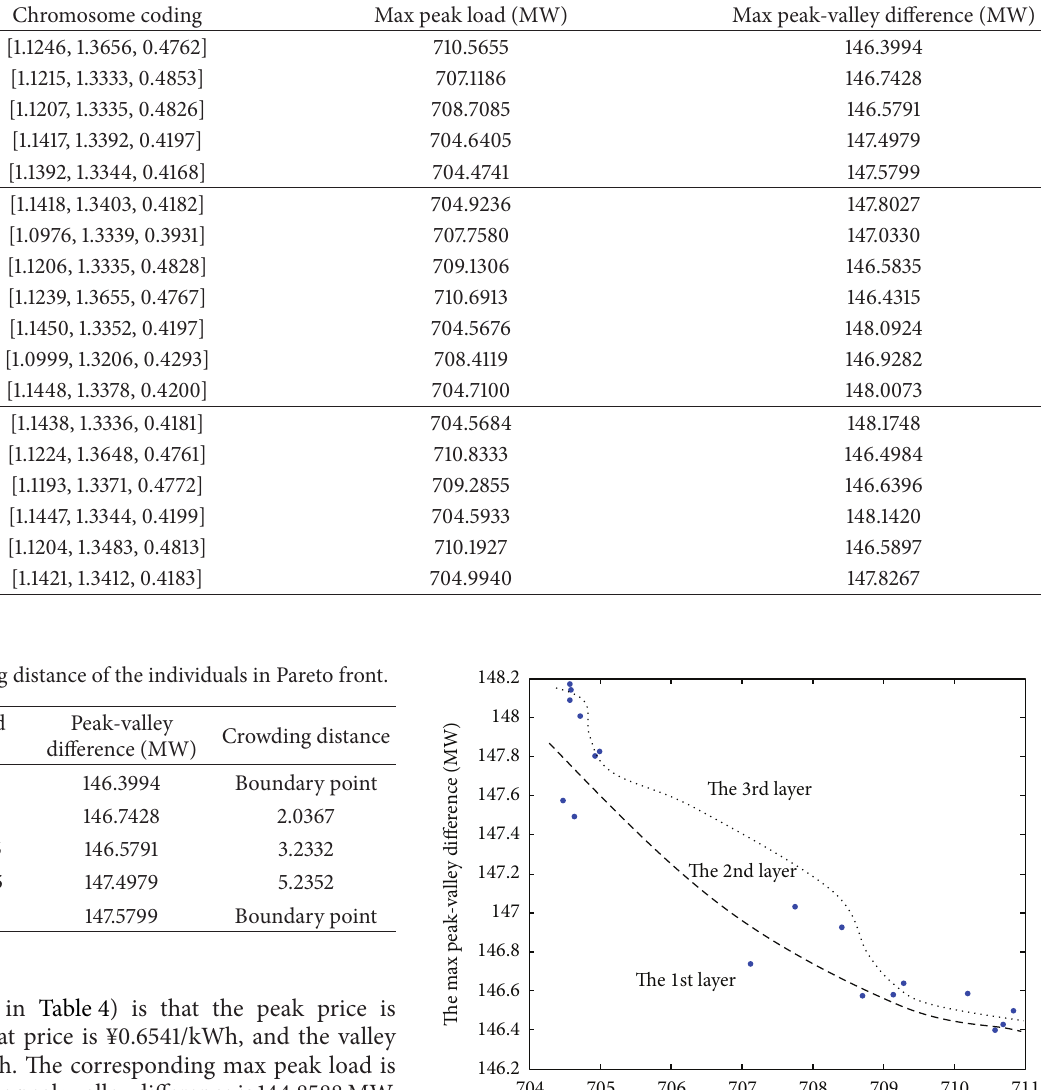
Table 2: The first 3 layers of the 10th generation (accurate to 0.001).